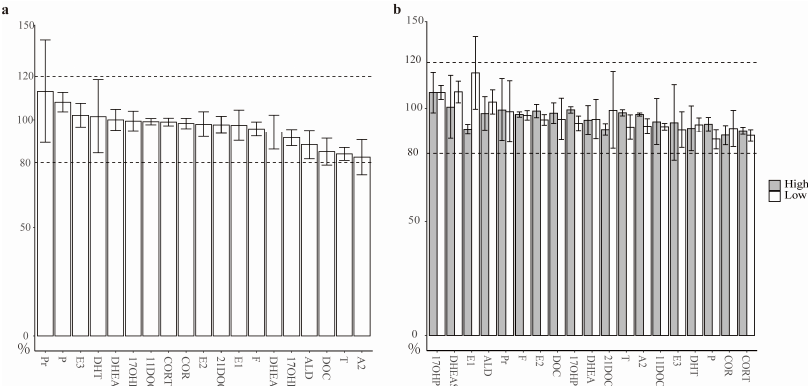
Figure 1. Assessment of data quality for quantification of the steroid hormones in AH using LC MS/MS. ( a ) The matrix effect of AH on steroid hormones. ( b ) The recoveries of steroid hormone extraction at high (solid bar) and low (hollow bar) concentration levels. The upper dashed line represents the recovery at 120%, and the lower dashed line represents the recovery at 80%.